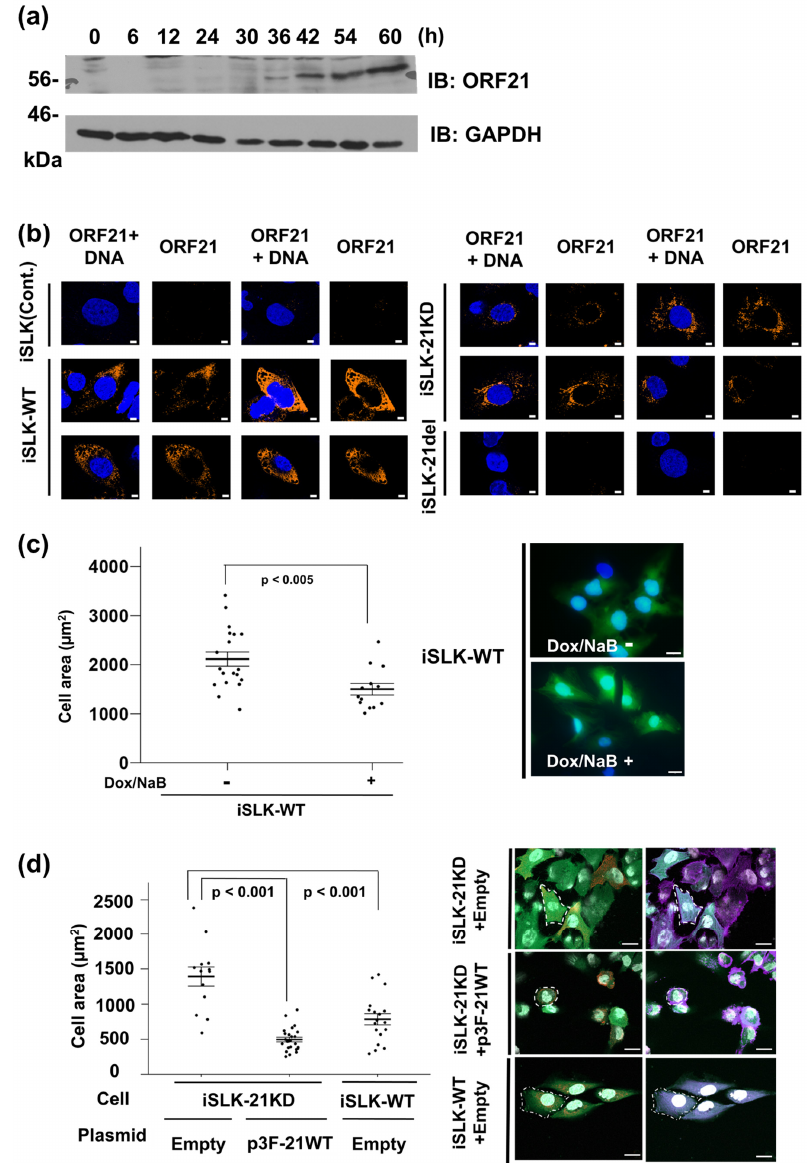
Figure 2. ORF21 is localized in the cytoplasm and is involved in cell contraction. ( a ) The endogenous expression of ORF21 protein in lytic-induced cells. iSLK-WT cells were treated for 0–60 h with NaB and Dox for lytic reactivation, and lytic-induced cells were analyzed by Western blotting using the